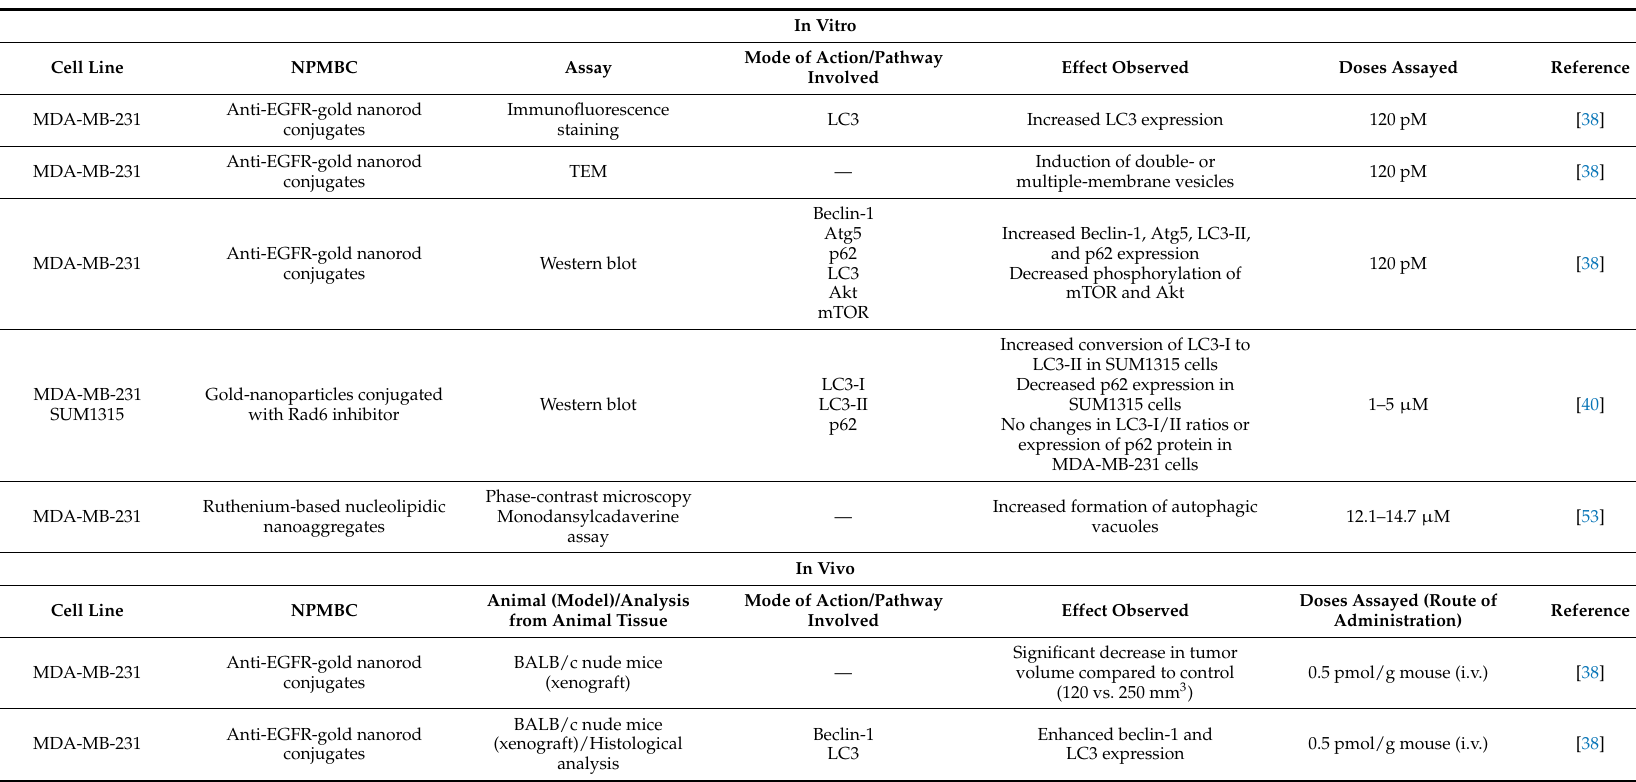
Table 4. Non-platinum metal based complexes (NPMBC) inhibit the in vitro and in vivo growth of triple-negative breast cancer (TNBC) cells by inducing autophagic cell